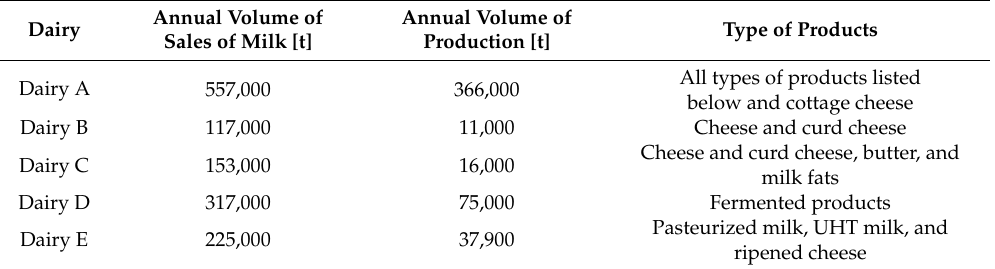
Table 1. Characteristics of dairies in terms of annual volume of sales of milk, annual volume of production, and type of